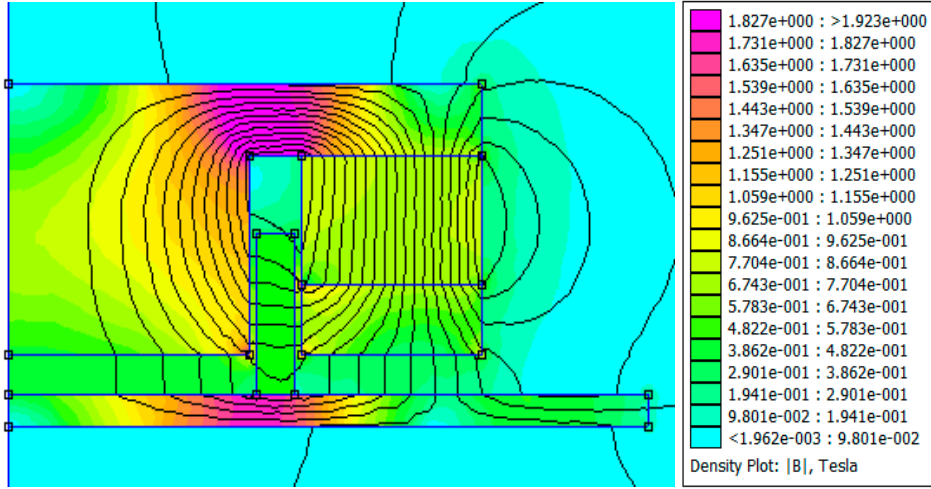
Figure 3. Magnetic flux density result of vertical magnetization model.